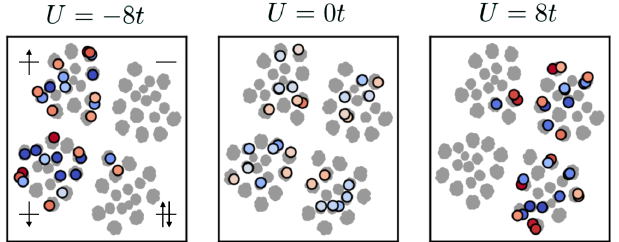
FIG. 3. Two-dimensional t-SNE projection of the Hilbert space of a half-filled 1D Hubbard chain of eight sites. The four clusters are specified by the occupancy of the reference site of the configurations (clockwise from the top left: spin-up electron, holon, doublon, and spin-down electron). The colored points are the 30 configurations selected by the RVM as the most relevant, with red and blue colors indicating positive and negative